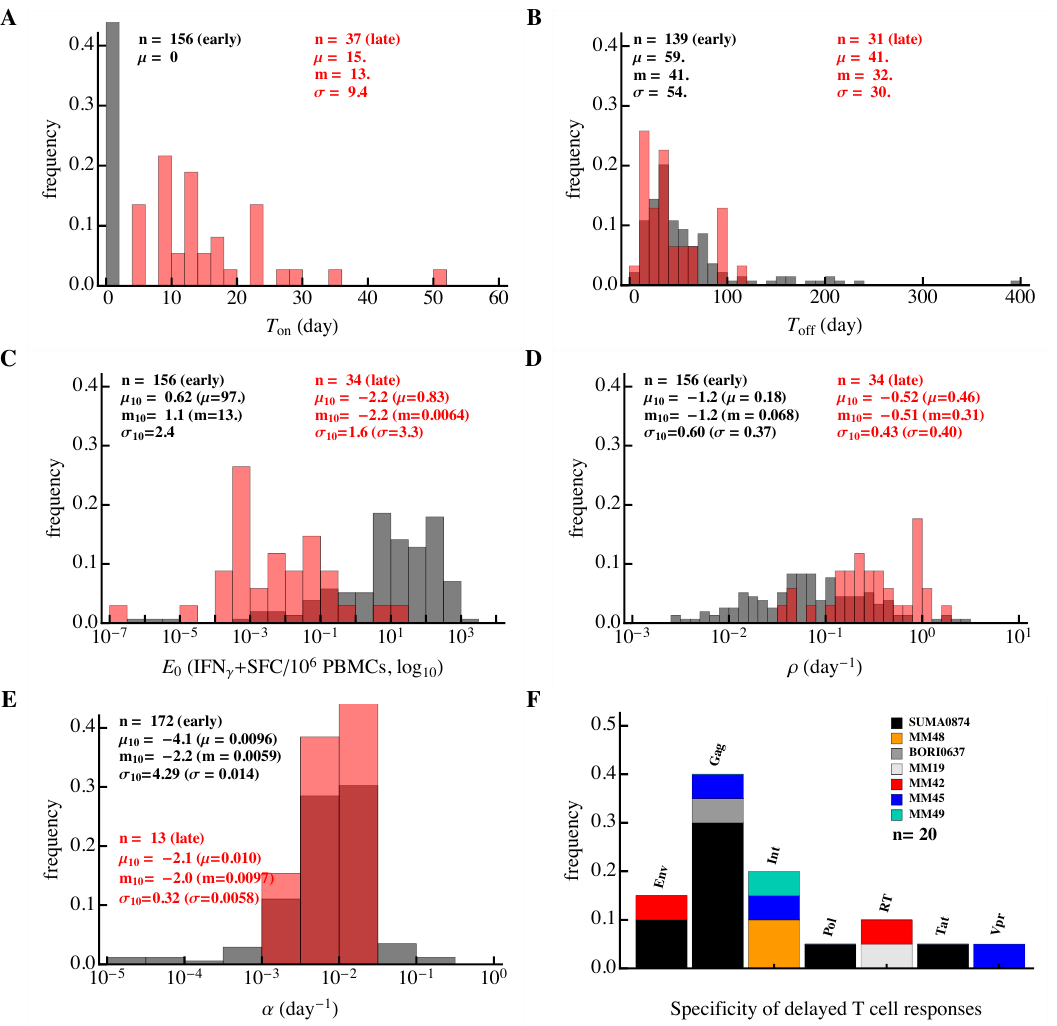
Figure 6. Differences in the kinetics of early and late HIV-specific CD8 + T-cell responses. We fitted the T on / T off model (Equation (1)) to the data on the dynamics of epitope-specific CD8 + T-cell response in each patient and plotted the distribution of the estimated parameters. The results are presented separately for T cell responses that started expanding (or contracting) from the first observation (“early” responses, about 80% of all responses; black) or delayed responses, which were undetectable at one or several initial time points (“late” responses; red). Panels show distributions for ( A ) time of expansion of T-cell response ( T on ), ( B ) time to peak of each T-cell response ( T off ), ( C ) initial predicted frequency of epitope-specific CD8 + T cells ( E 0 ), ( D , E ) expansion ( ρ ) and contraction ( α ) rates of T-cell responses, respectively, and ( F ) proteins recognized by late CD8 + T-cell responses. In ( A – E ), n represents the number of fitted responses, and µ , m and σ represent mean, median and standard deviation, respectively ( µ 10 , m 10 , and σ 10 are mean, median, and standard deviation for log parameters). Late responses were predicted to have a higher expansion rate ρ